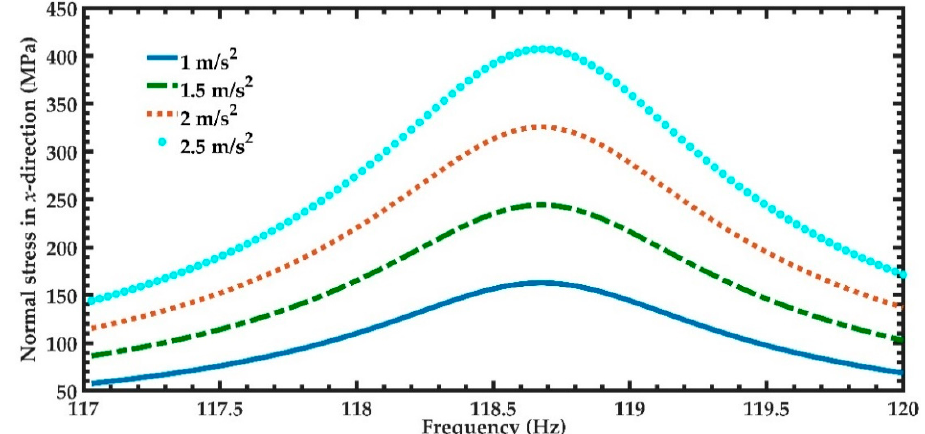
Figure 13. Maximum dynamic deflection of the nanogenerator considering four different accelerations in y -direction and a frequency range from 117 to 120 Hz.